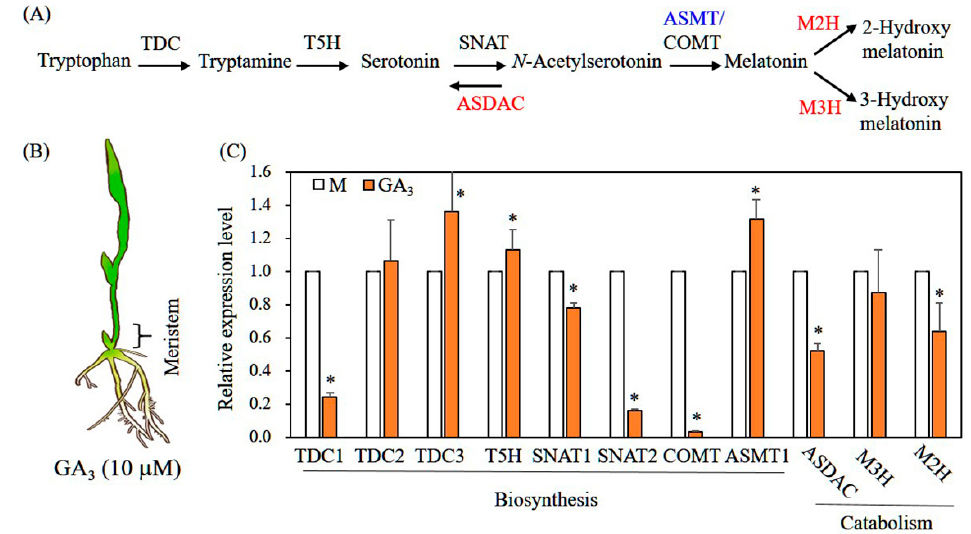
Figure 4. Expression levels of transcripts encoding melatonin biosynthetic and catabolic genes. ( A ) Genes involved in melatonin biosynthesis and catabolism in plants. ( B ) Schematic representation of rice seedlings treated with GA 3 and the apical meristem region. ( C ) Quantitative reverse-transcription polymerase chain reaction (qPCR) analysis of various genes involved in melatonin synthesis and catabolism. Asterisks (*) denote significant differences from the mock control (M) ( p < 0.05; ANOVA, followed by Tukey’s HSD post hoc tests). TDC1 , tryptophan decarboxylase 1 (AK069031);